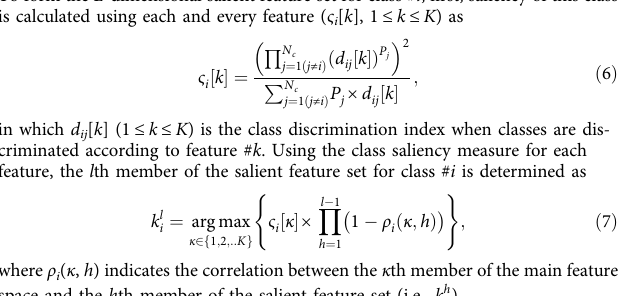
Fig. 9 Illustration of class discrimination indices ( d three spike classes in a two-dimensional feature space. Each class